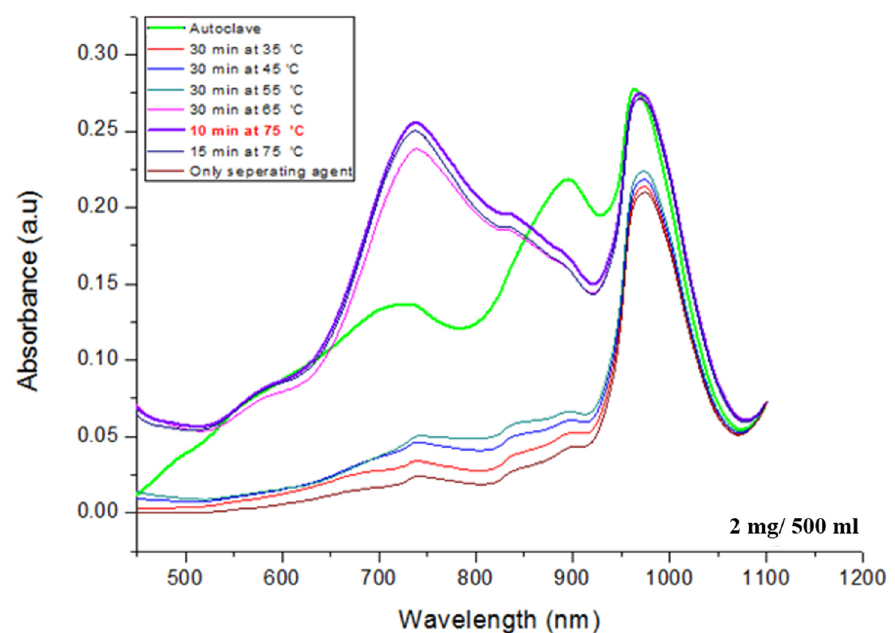
Figure 10. Measured absorbance of the pretreated test solution (2 mg / 500 mL) using the thermally enhanced photocatalytic reaction based microfluidic chip and autoclave.